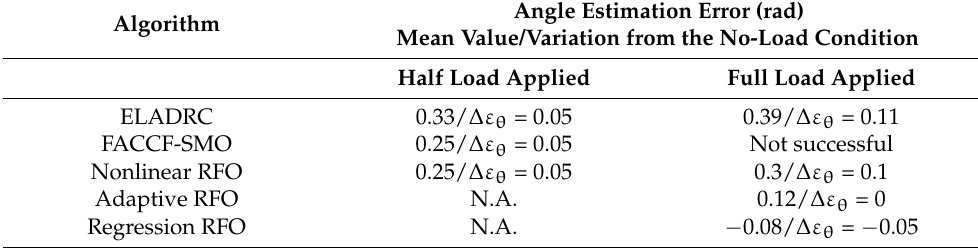
Table 3. Position estimation error after appliance of load steps at 10% of rated speed.